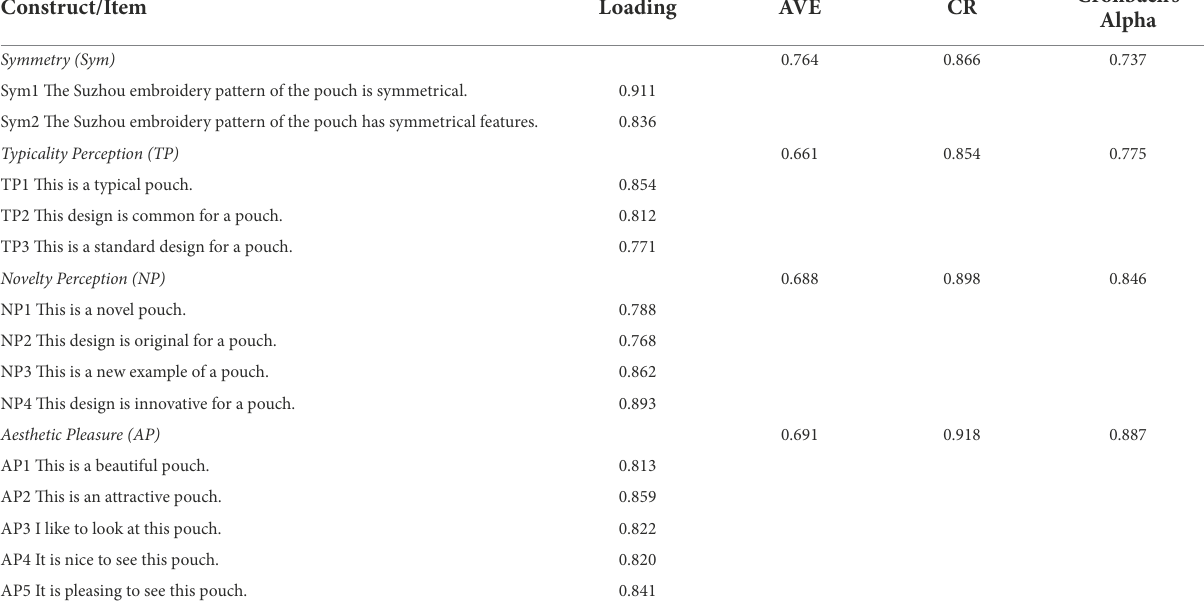
TABLE 1 Reliability and convergent validity. Construct/Item